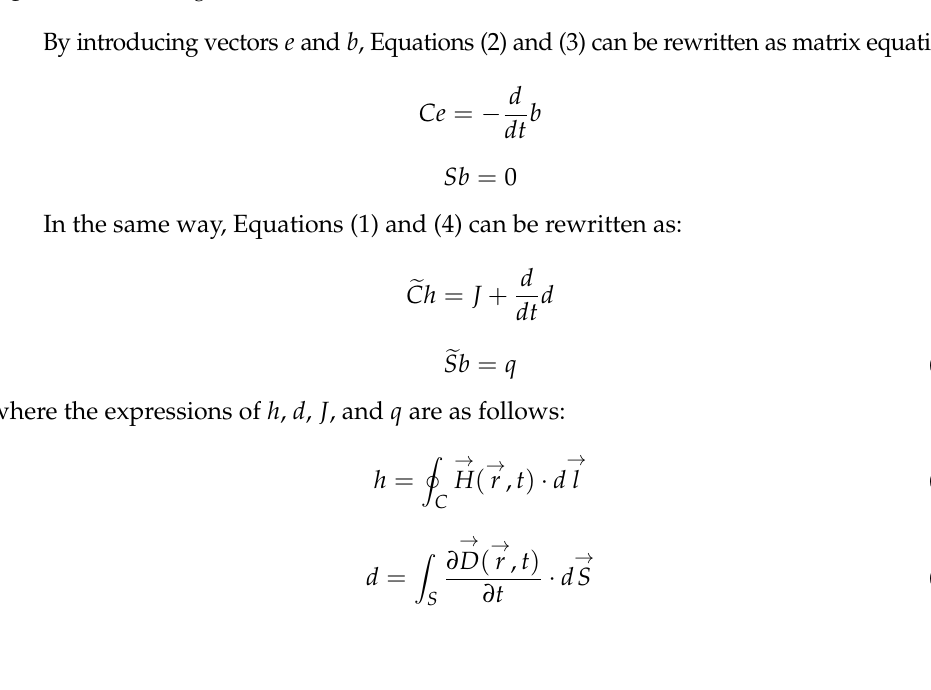
( b ) Figure 2. Experimental facilities layout: ( a ) schematic diagram and ( b ) practical measurement diagram.